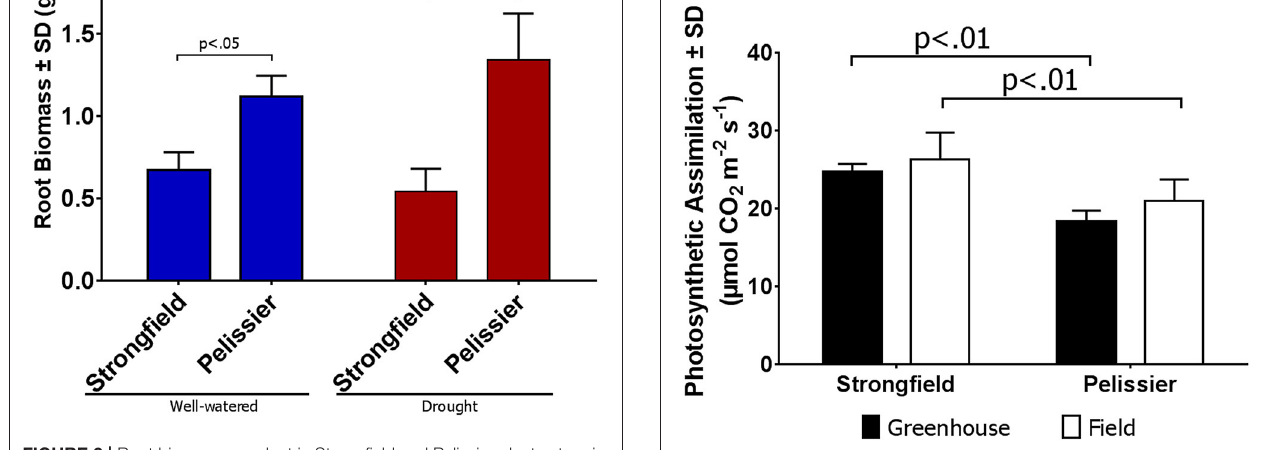
FIGURE 2 | Root biomass per plant in Strongfield and Pelissier plants at grain filling stage on dry weight basis. Roots from 4 plants of each line in each condition were harvested in grain filling period from root boxes 3 weeks after the water holding capacity reached 25% (drought); the well-watered controls were maintained at 95% capacity.